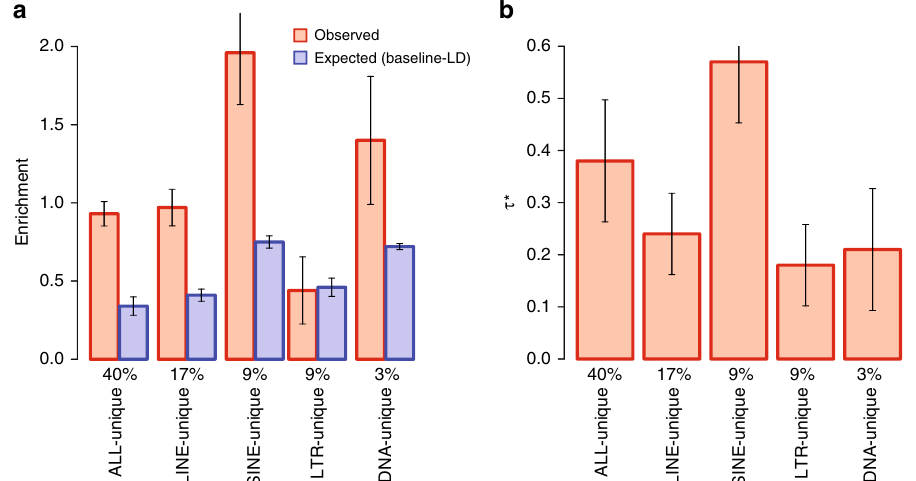
Fig. 4 Robustness of results to dif fi culty in mapping to TE regions. For each of LINE-unique, SINE-unique, LTR-unique, DNA-unique, and ALLTE-unique, we report a two measures of heritability enrichment: observed and expected (baseline-LD); and b standardized effect size ( τ *), which quanti fi es effect that are unique to the focal annotation. Results are meta-analyzed across 41 independent traits. Numerical values of %SNPs are provided for each annotation. Error bars denote 95% con fi dence intervals. Numerical results are reported in Supplementary Table